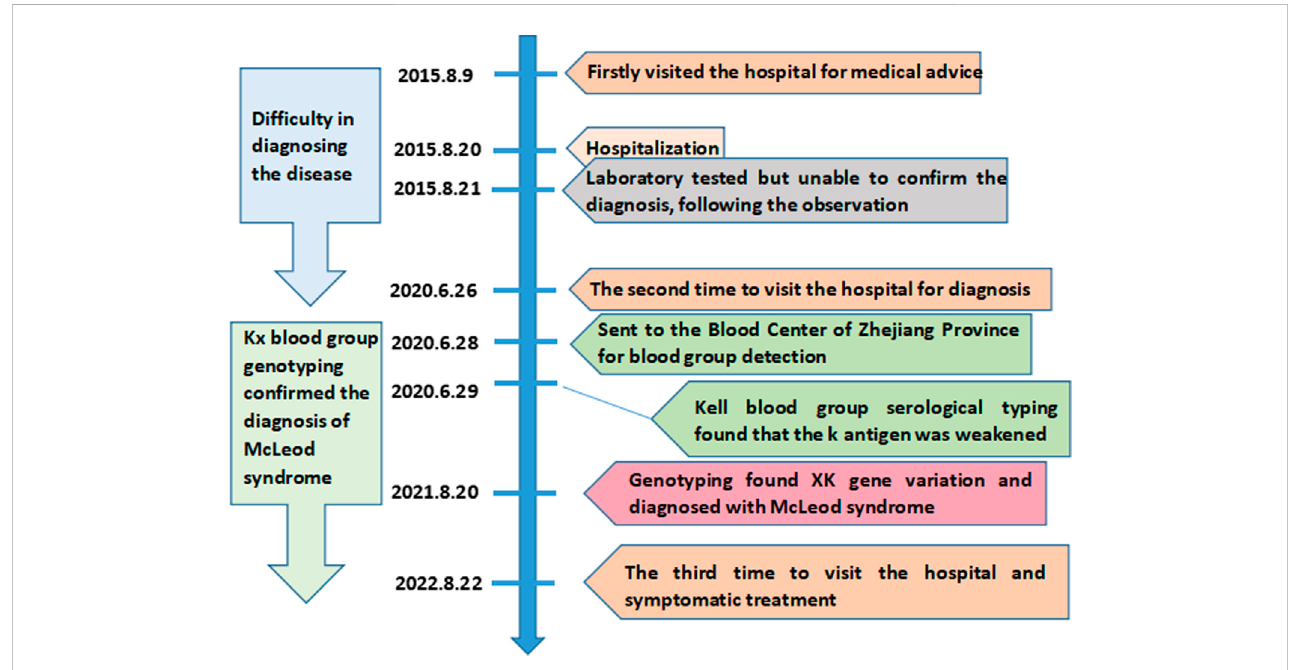
FIGURE 1 Timeline of the patient ’ s medical